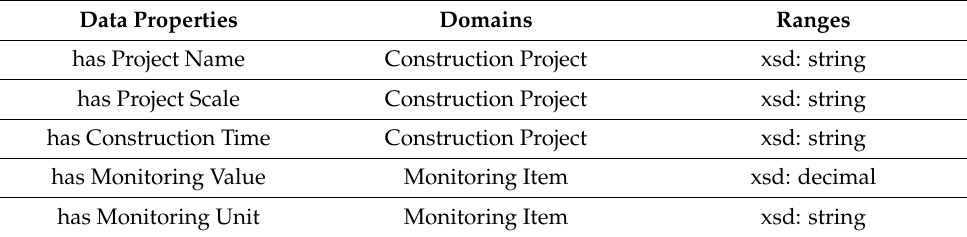
Table 3. Definition of data